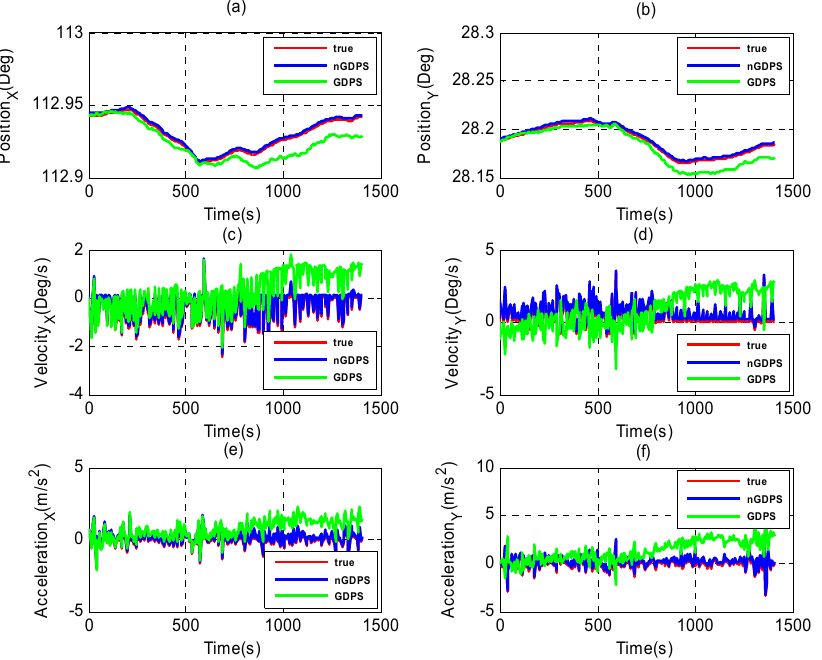
Figure 4. Estimate results of nGDPS and GDPS versus true vehicle state in (X, Y)-coordinates: ( a , b ) Position; ( c , d ) Velocity; and ( e , f ) Acceleration.